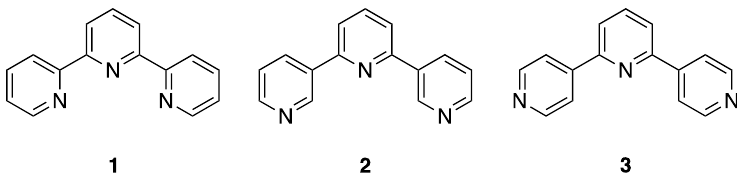
Figure 1. The structure of the most commonly encountered terpyridine, 2,2′:6′,2′′ -terpyridine ( 1 ), together with the closely related compounds 3,2′:6′,3′′ -terpyridine ( 2 ) and 4,2′:6′,4′′ -terpyridine ( 3 ).